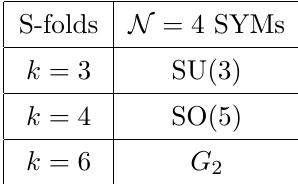
Table 2 . N = 4 SYMs expected to be equivalent to S ( k; 2 ;